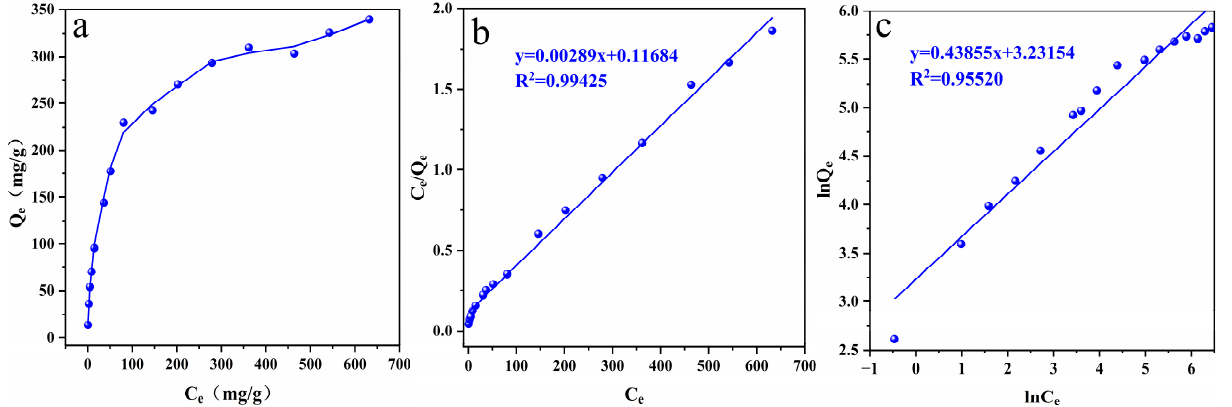
Figure 6. Adsorption isotherm of ReO 4 − by p-(Amide)-PAM ( a ): fitting the Langmuir model ( b ) and fitting the Freundlich model ( c ). The dosage of the absorbent was 1 g/L, pH was 5.5, time was 12 h, initial concentration of ReO 4 − was 0–1000 mg/L, and the temperature was 298.15 K. Table 2. Fitting parameters of the Langmuir model and Freundlich model. Table 3. Adsorption capacity of 99 TcO 4 − /ReO 4 − by different adsorption materials.